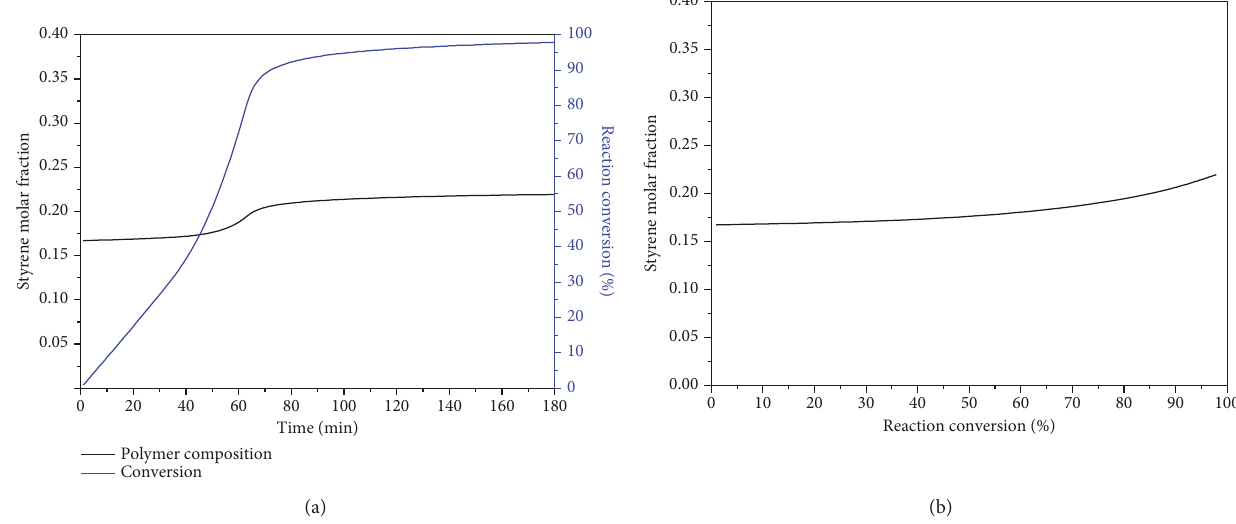
Figure 2: Conversion and composition pro fi les: gel and glass e ff ects. I = 0 17 mol, M = 0 454 , r = 0 472 , r = 0 454 , s = 0 412 , and s r 12 21 22 1